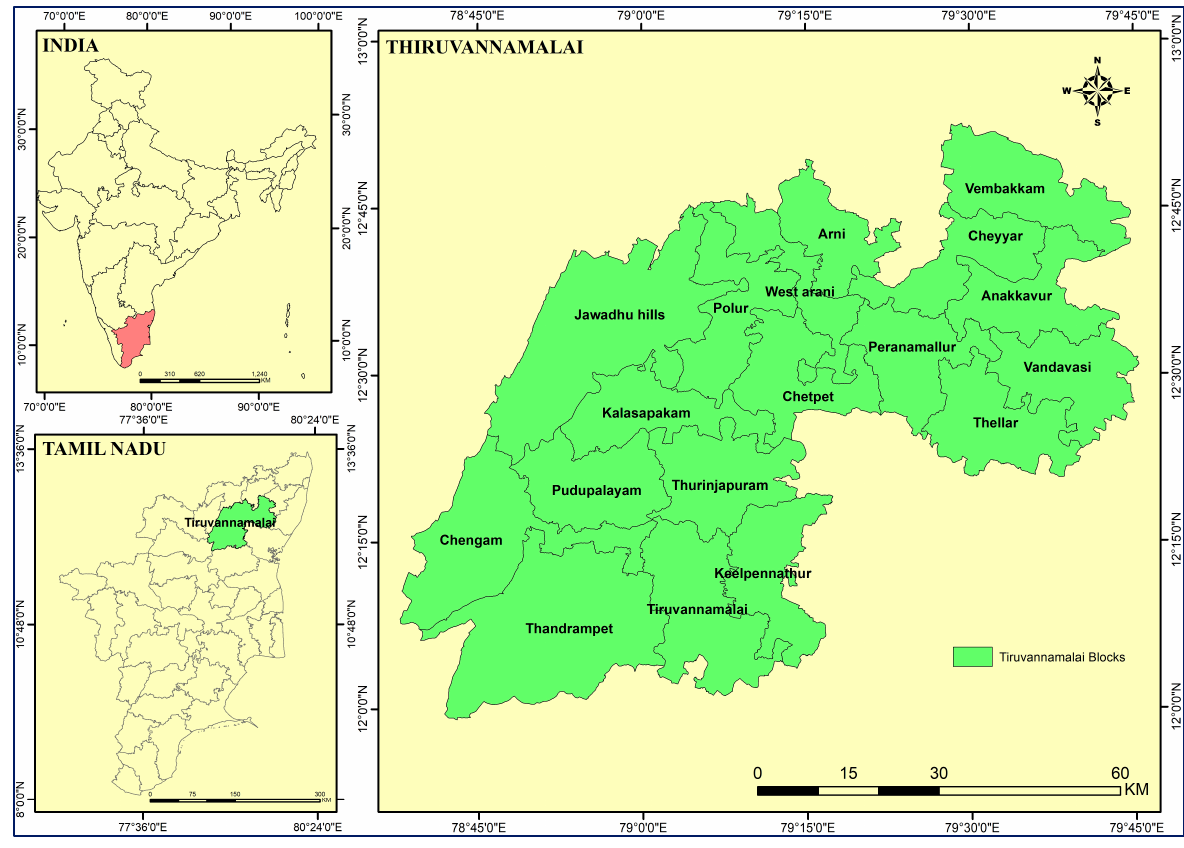
Figure 1. Study area map for Tiruvannamalai district.